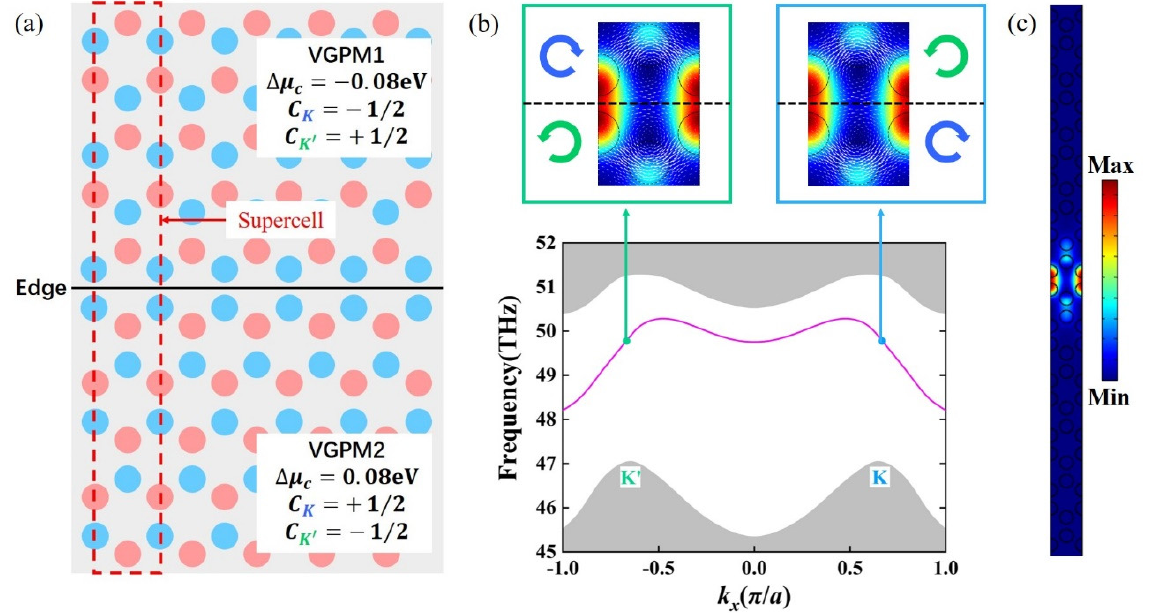
Figure 3. Valley topological edge states. ( a ) Schematic of the valley topological interface constructed by VGPM1 with ∆ µ c = − 0.08 eV (top) and VGPM2 with c = 0.08 eV (bottom). Red dotted rectangle: supercell for the valley topological interface. ( b ) Dispersion of the valley topological edge states (magenta line) for the designed supercell. Grey-shaded regions: projected TM polarized bulk bands. Insets: edge states at the K and K’ points. Color: | E | 2 ; white arrows: power flux. ( c ) The photonic light field for the designed supercell at the K/K’ points.